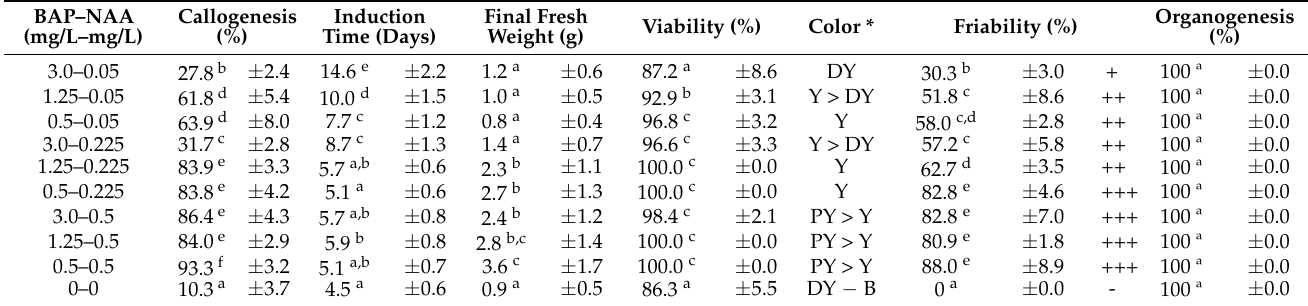
Table 5. Developmental and morphological parameters of T. officinale callus derived from hypocotyls induced under different NAA/BAP combinations (medium MS supplemented with sucrose 2.3%, at 18 ± 2 ◦ C and 0/24 h light/dark, four weeks after